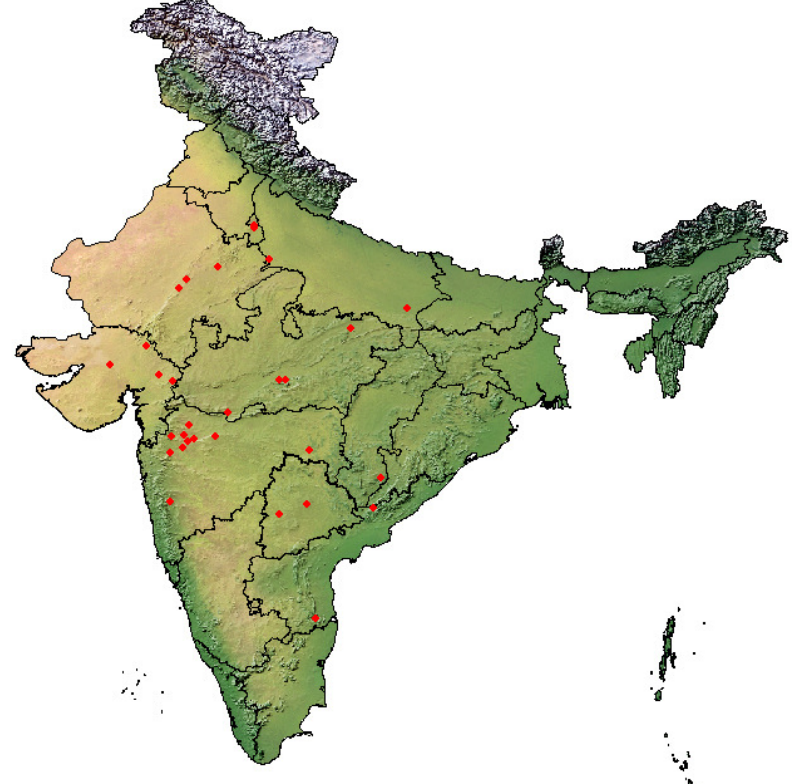
Figure 2. Distribution of Chersonesometrus fulvipes (C.L. Koch, 1837) in India Chersonesometrus madraspatensis (Pocock,